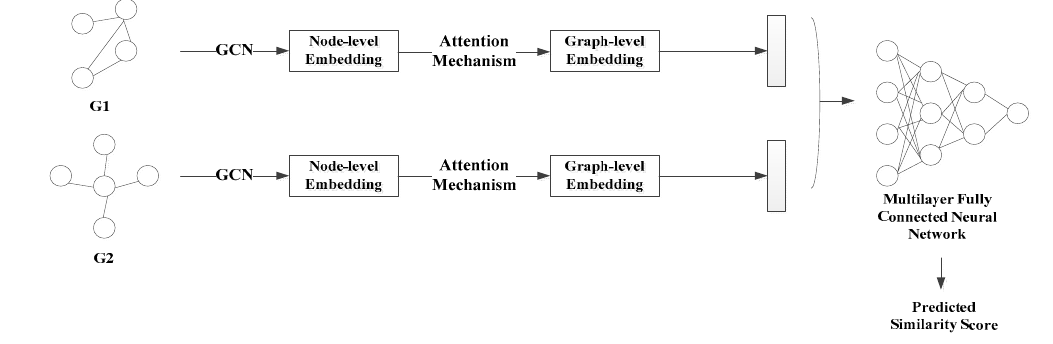
Figure 2. The framework of the graph matching model.